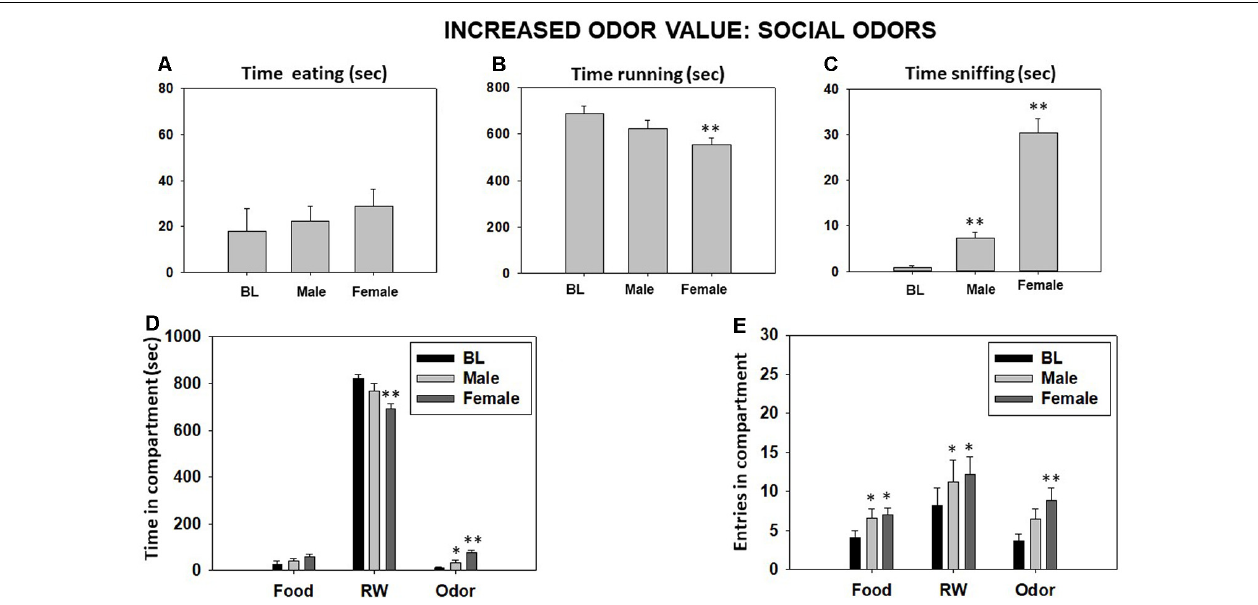
FIGURE 5 | Effect of changing from fruit odor to social odors in the odor compartment of the T-maze task on time eating (A) , time running (B) , time sniffing (C) , time spent in each compartment (D) , and entries into compartments (E) in the T-maze task assessed during 15 min. Bars represent mean ± SEM of accumulated seconds or number of entries. ∗ p < 0.05, ∗∗ p < 0.01 significantly different from BL.